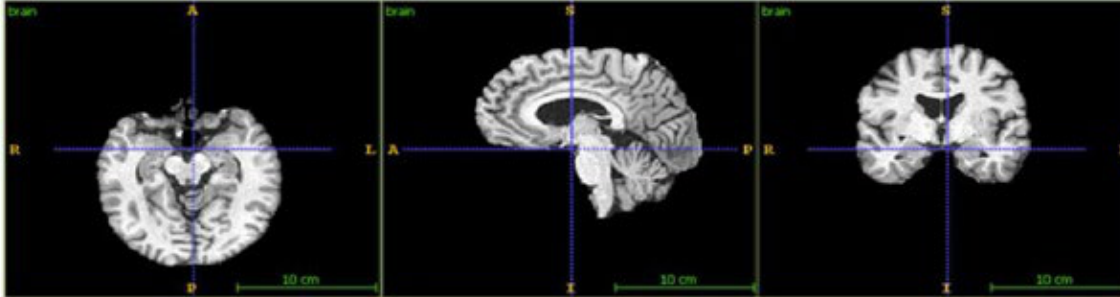
Figure 9. The brain extraction process.